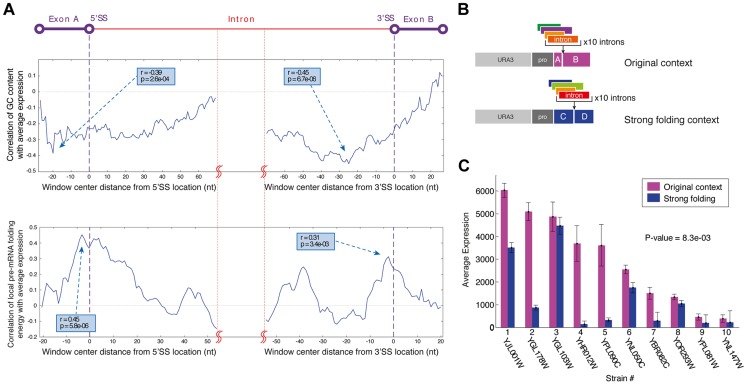
The exonic context of introns is a major regulatory determinant of gene expression.A) Profiles of the correlation of GC content (top) and local mRNA folding energy (bottom) around the 5′SS and 3′SS with YiFP expression levels identified these features as determinants affecting gene expression. Sliding window sizes are 50 nt for GC content and 40 nt for folding energy. B) Ten introns were inserted into a stronger folding location in the YFP to test this feature's effect on gene expression. C) Introns inserted into a location within the YFP reporter with stronger folding (blue) confer lower expression levels. Averages of three independent experiments are presented (paired t test p = 8.3e-03).